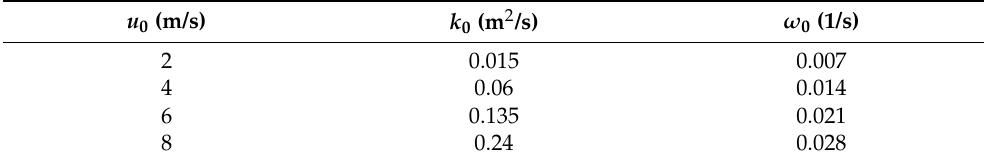
Table 2. k 0 and ω 0 values at the inlet